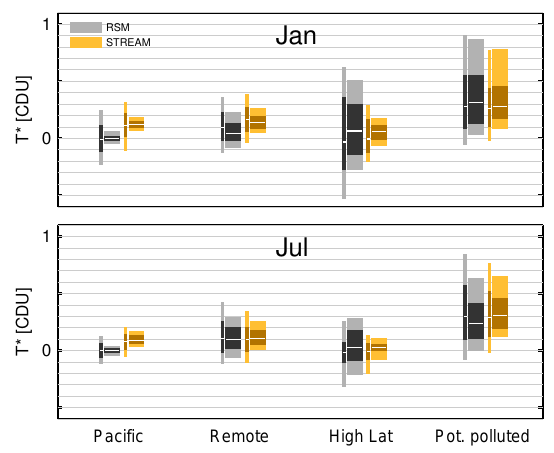
Figure 6. Regional statistics of OMI tropospheric residues T ∗ from RSM and STREAM for January (top) and July (bottom) 2005. Light and dark bars reflect the 10–90th and 25–75th percentiles, respectively. The median is indicated in white. Narrow bars show the statistics for the first day of the month, wide bars those of the monthly means (see also Fig. S8 left for illustration). The regions are defined in Fig. S8 right. “High latitudes” refer to the respective hemispheric winter